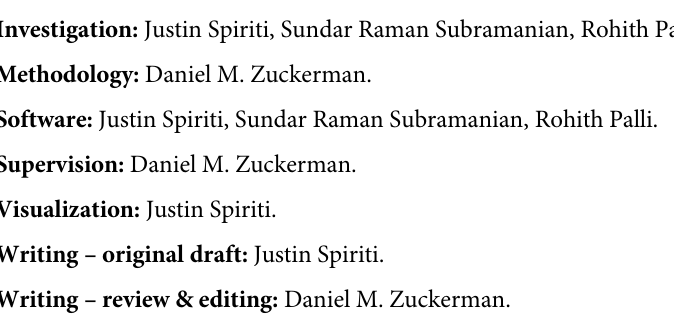
S2 Table. Antagonists used in this work. S1 Fig. Analysis of NCMC and MC acceptance probabilities in docking simulations of estradiol to the active conformation of ER α as a function of move size. (a), (c), and (e) are for translations; (b), (d), and (f) are for rotations. (a)-(b) Cumulative probability density func- tion of generated move sizes. (c)-(d) Average final acceptance probability of NCMC and MC moves as a function of move size. (e)-(f) Combined acceptance probability (the overall propor- tion of all NCMC or MC moves that were accepted and of the given size) which is the product of the generating probability. S2 Fig. Plots of ligand RMSD relative to crystal structure vs. number of trial moves in docking simulations. (a) genistein; (b) diethylstilbestrol; (c) raloxifene; (d) the drug AIU. Six out of 120 docking runs are shown for each